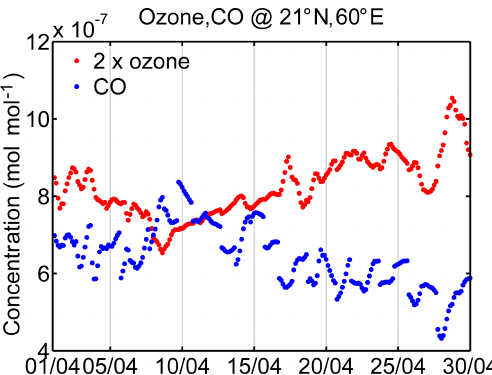
Figure A1. O 3 and CO partial column (4–8km) time series at 21 ◦ N, 60 ◦ E over AS at April 2008 from MACC reanalysis data. The plot is a “point” example of Fig. 10.